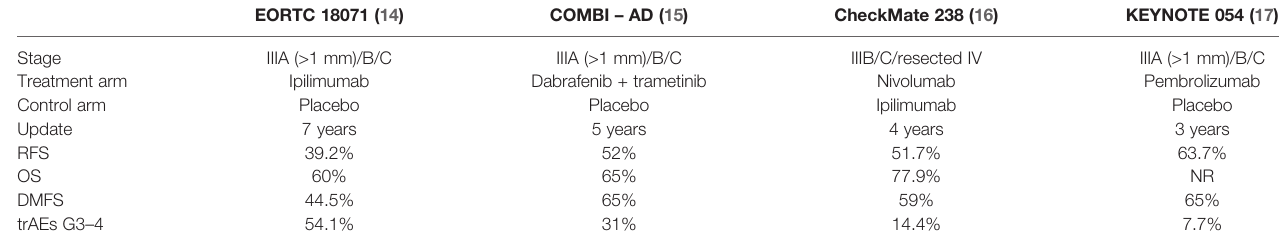
TABLE 1 | Update on the latest results of adjuvant clinical